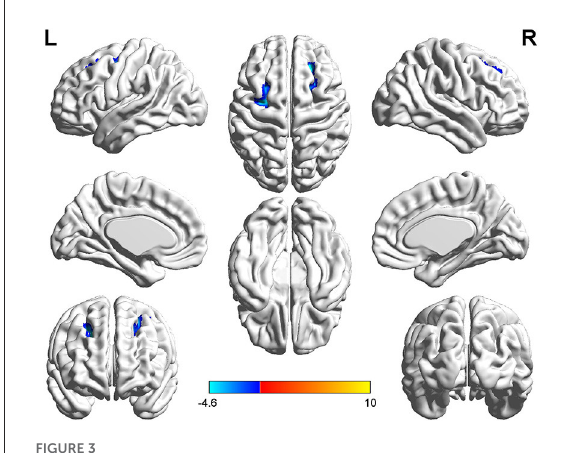
FIGURE3 T -value map of differential results of mReHo between left auditory neuroma and healthy controls. Compared with healthy controls, the brain regions with decreased mReHo in the patients with left acoustic neuroma were: the bilateral superior and middle frontal gyrus, with no significant decrease in the brain regions. The statistical threshold was voxel-wise p < 0.001 with cluster-wise FWE corrected p < 0.05 (122 voxels).